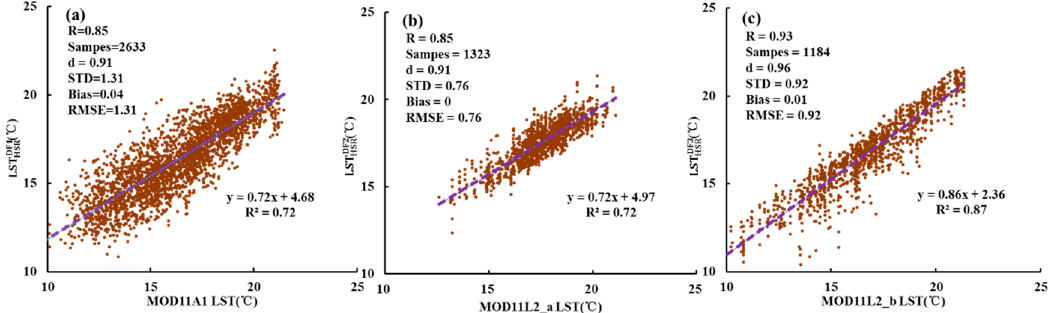
Figure 5. Scatter plots of the HSR fused LST ( 𝐿𝑆𝑇 (cid:3009)(cid:3020)(cid:3019)(cid:3005)(cid:3007) ) against its corresponding MODIS LST product in Case 1 on 13 September, 2015. ( a ) MOD11A1 vs 𝐿𝑆𝑇 (cid:3009)(cid:3020)(cid:3019)(cid:3005)(cid:3007)(cid:2869) . ( b ) MOD11L2_a vs 𝐿𝑆𝑇 (cid:3009)(cid:3020)(cid:3019)(cid:3005)(cid:3007)(cid:2870) . ( c ) MOD11L2_b vs 𝐿𝑆𝑇 (cid:3009)(cid:3020)(cid:3019)(cid:3005)(cid:3007)(cid:2871) . The HSR fused LST is resampled to match the spatial resolution of MODIS LST.